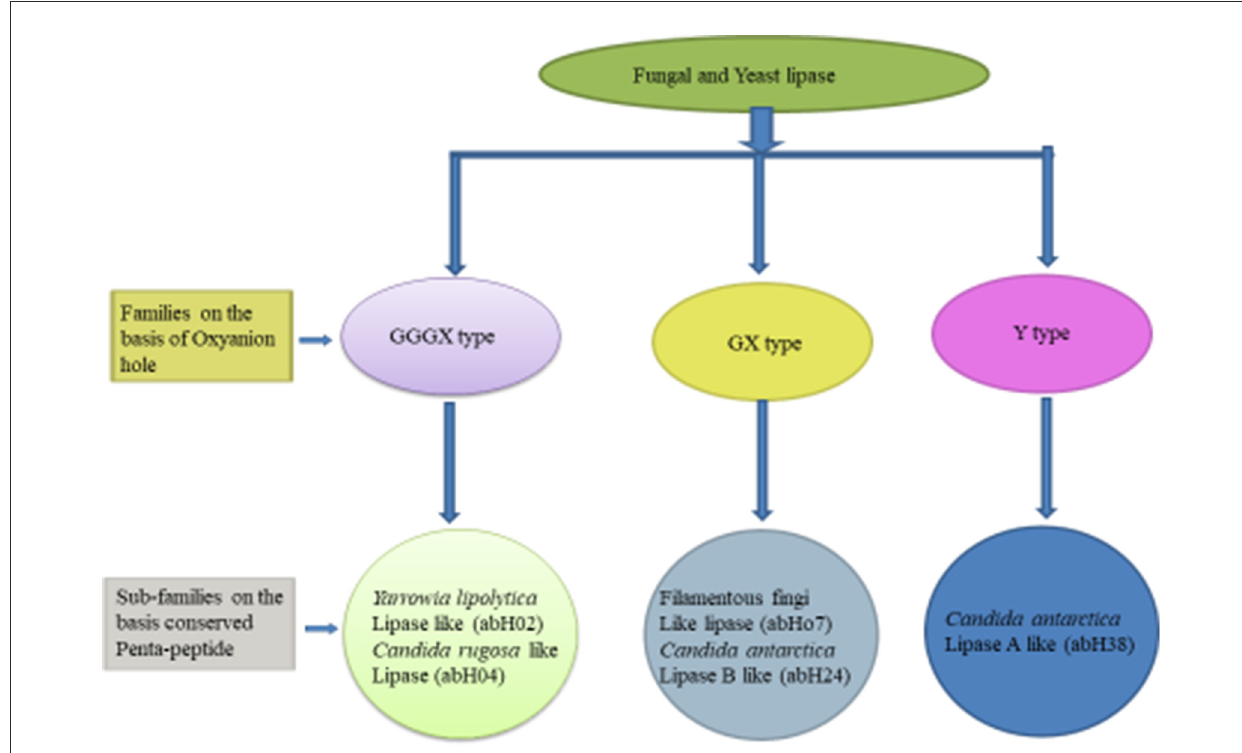
FIGURE1 Classification of fungal and yeast lipase (Mehta et al., 2017; Mahfoudhi et al., 2022).